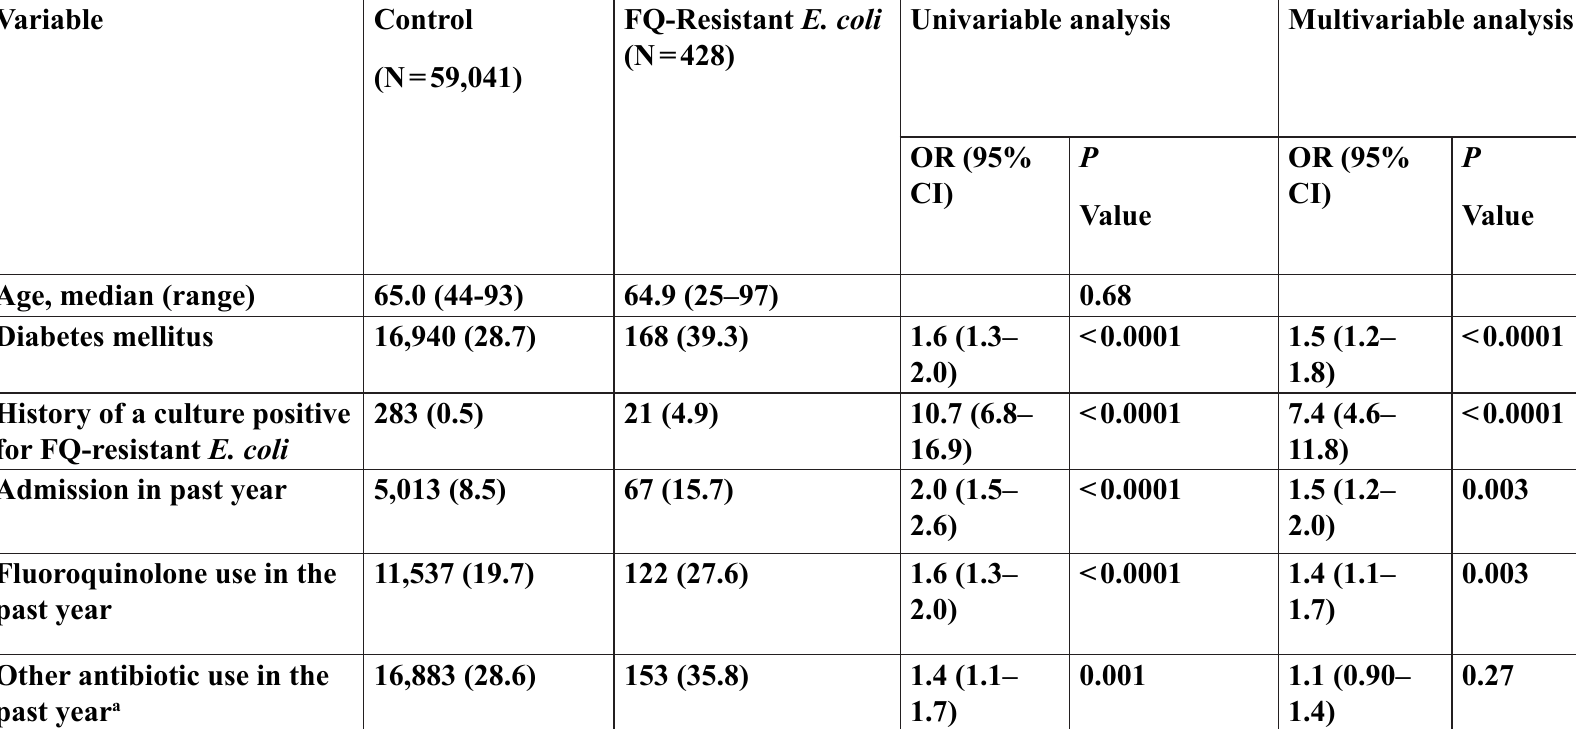
Risk Factors for Fluoroquinolone-Resistant Escherichia coli Bacteriuria After Transrectal Biopsy of the